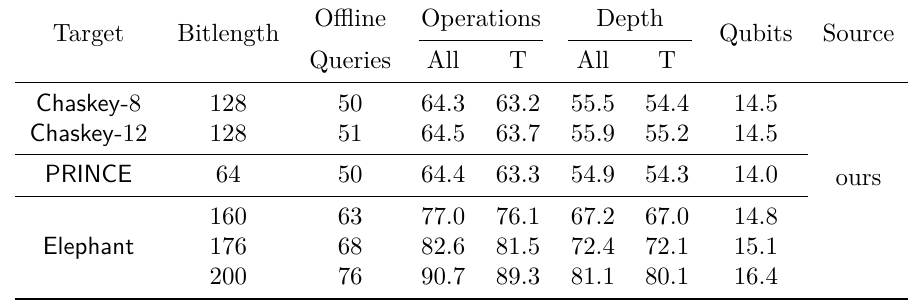
Table 3: Offline Simon attack costs without a query limit. All figures in log base 2 except